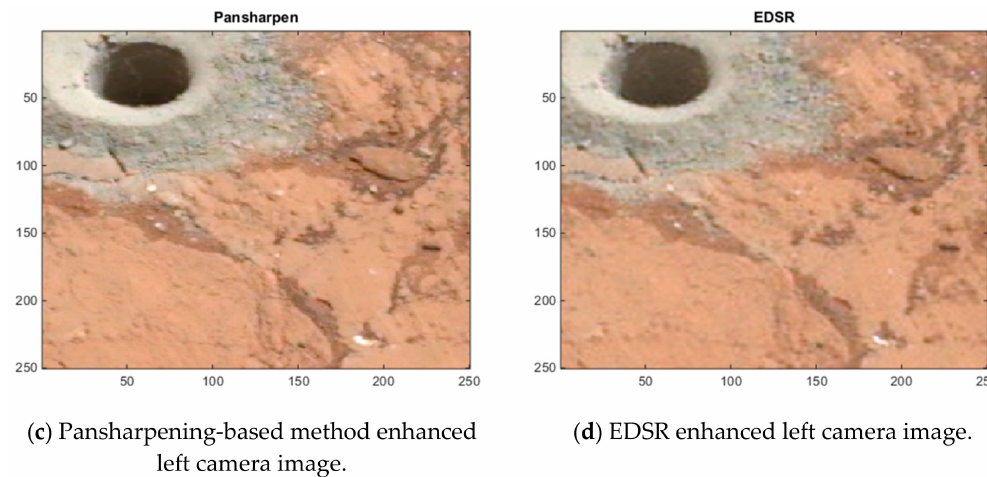
Figure 14. Image enhancements on